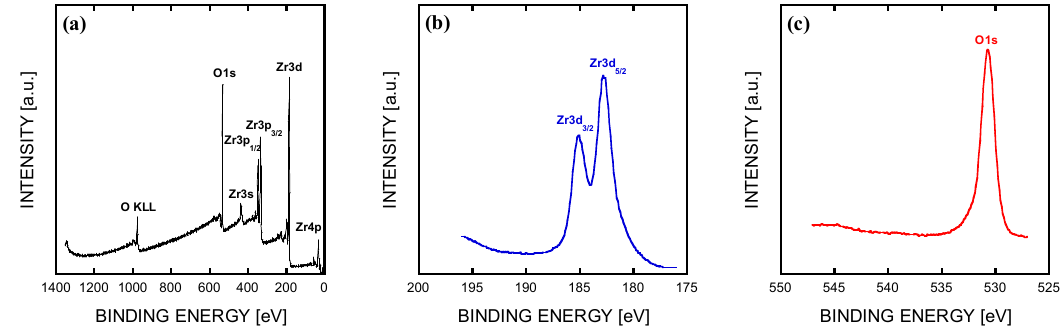
Figure 4. X-ray photoelectron spectrometry of ALD-based ZrO 2 thin films: ( a ) survey spectrum, ( b ) core spectrum of Zr 3 d, ( c ) core spectrum of O 1 s. Sample information: deposition temperature: 150 °C, CMEN-Zr pulse time: 2.5 s, O 2 plasma pulse time: 9 s, PEALD cycle: 400 cycles (~38 nm), substrate: P-type silicon.